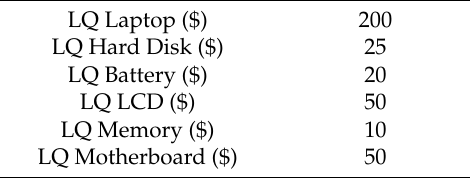
Table A1. Low-quality remanufactured laptop, subassembly, and component prices.